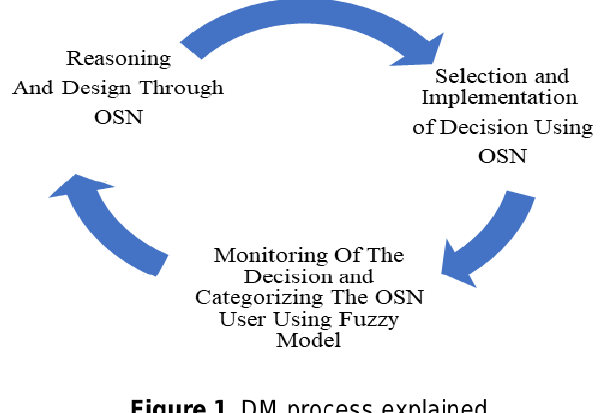
Figure 1. DM process explained